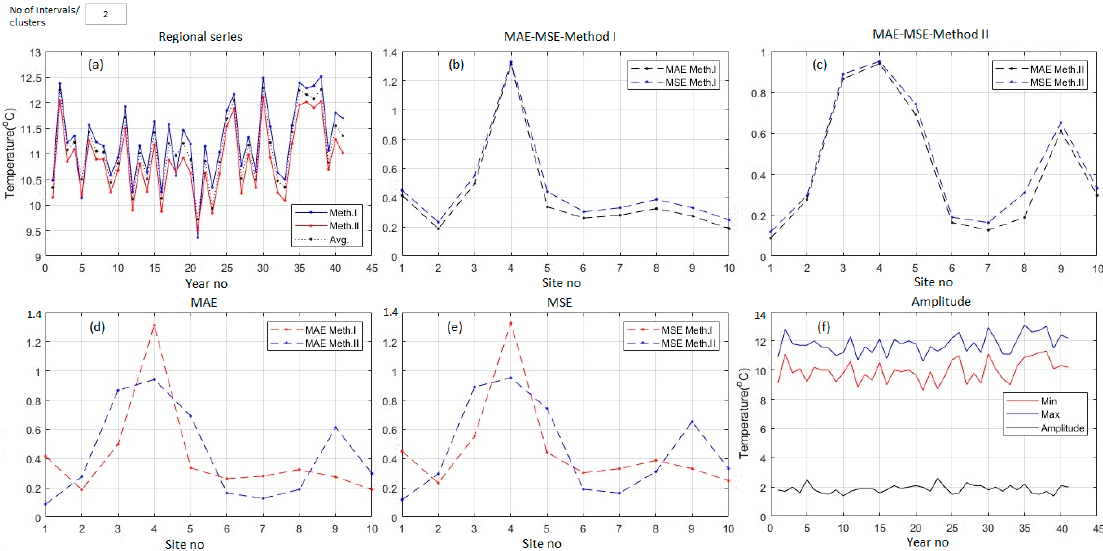
Figure 7. The case of two intervals/clusters for the series of average temperatures: ( a ) the regional series, ( b ) MAE and MSE—Method I; ( c ) MAE and MSE—Method II; ( d ) comparisons of MAEs; ( e ) comparisons of MSEs; ( f ) min, max, and amplitude of the average temperatures series.